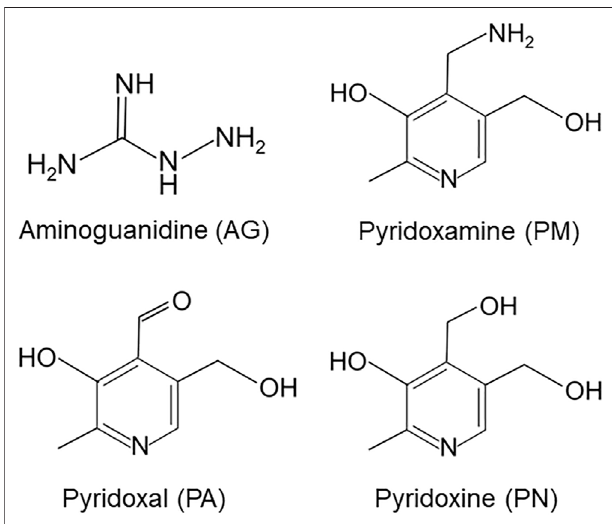
FIGURE 1 | Chemical structures of aminoguanidine (AG), pyridoxamine (PM), pyridoxal (PA) and pyridoxine (PN).